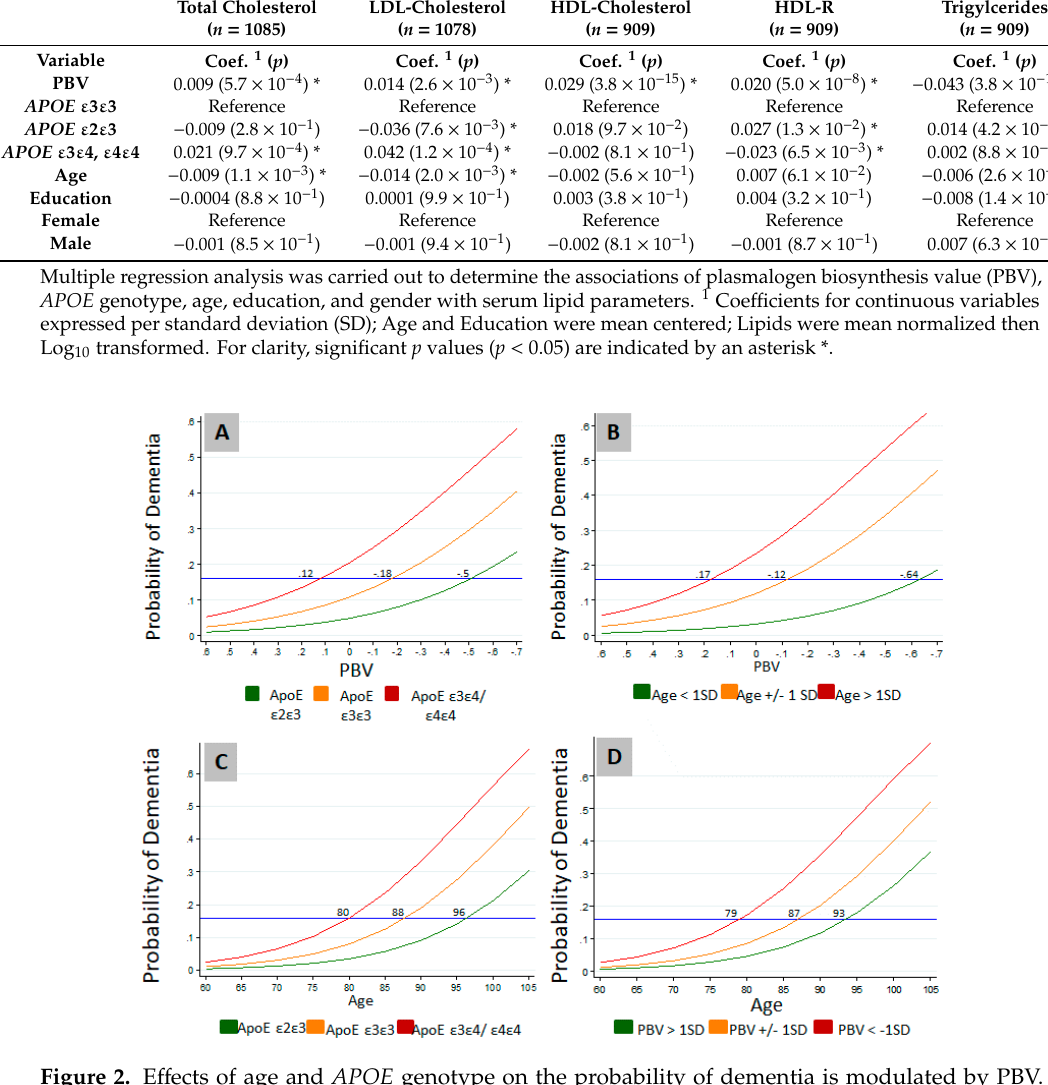
Table 4. Multivariate association of clinical and biological variables with serum lipids.